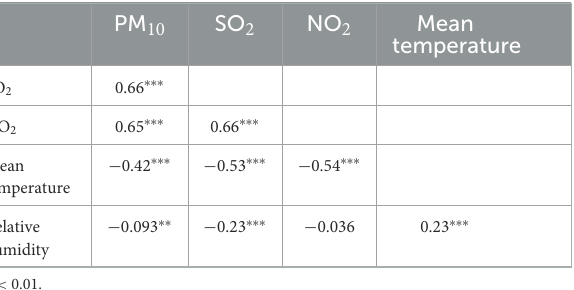
TABLE 2 Spearman correlation analysis of environmental variables in Linfen, China, from 2016 to